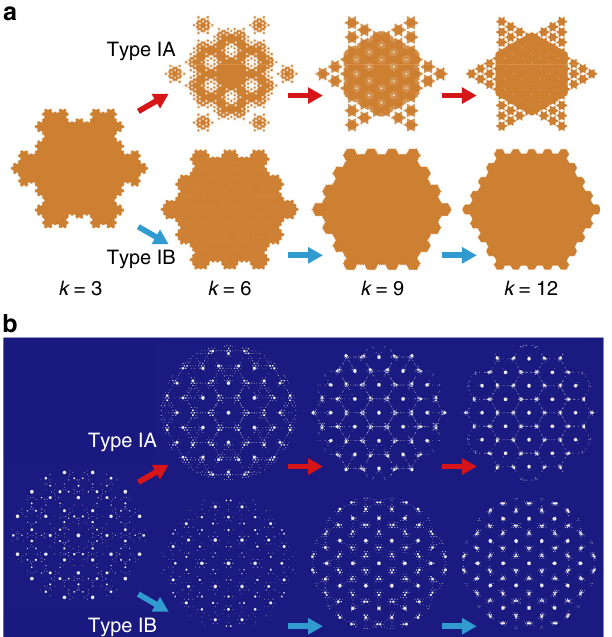
Fig. 3 Projection windows and Fourier transforms. a Windows of the k = 3, 6, 9, and 12 type IA tilings with 324391, 123392, 1212652, and 7195910 points, respectively (top row), and type IB tilings with 95659, 11041, and 32767 points, respectively; the windows are obtained based on third- generation tilings except for the k = 3 tiling ( fi fth generation) and k = 12 type IB tiling (second generation). b Transforms of these tilings with spots normalized relative to the central peak; shown are all spots with intensities I ( q ∥ ) >